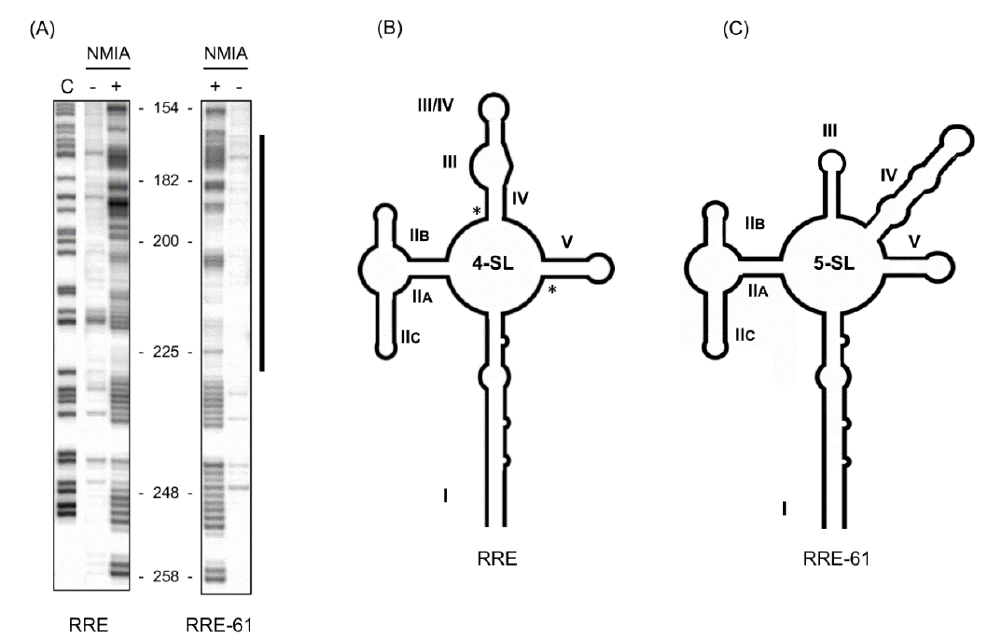
Figure 2. Mutations conferring resistance to trans-dominant RevM10 therapy induce a conformational change in the HIV-1 RRE. ( A ) Structural probing of the wild-type RRE (left) and RevM10-resistant RRE-61 (right). ( C ) Control DNA sequencing lane from which nucleotide numbering was derived. Designations − and + refer to untreated and NMIA-treated RNA, respectively. Major alterations in chemical reactivity are indicated by the bar. ( B , C ) Cartoons depicting SHAPE-derived conformations of wild-type RRE and RRE-61. SL, stem-loop. Positions of RRE point mutations, inducing RevM10 resistance, are indicated by asterisks in ( B ). Modified from Reference [47].